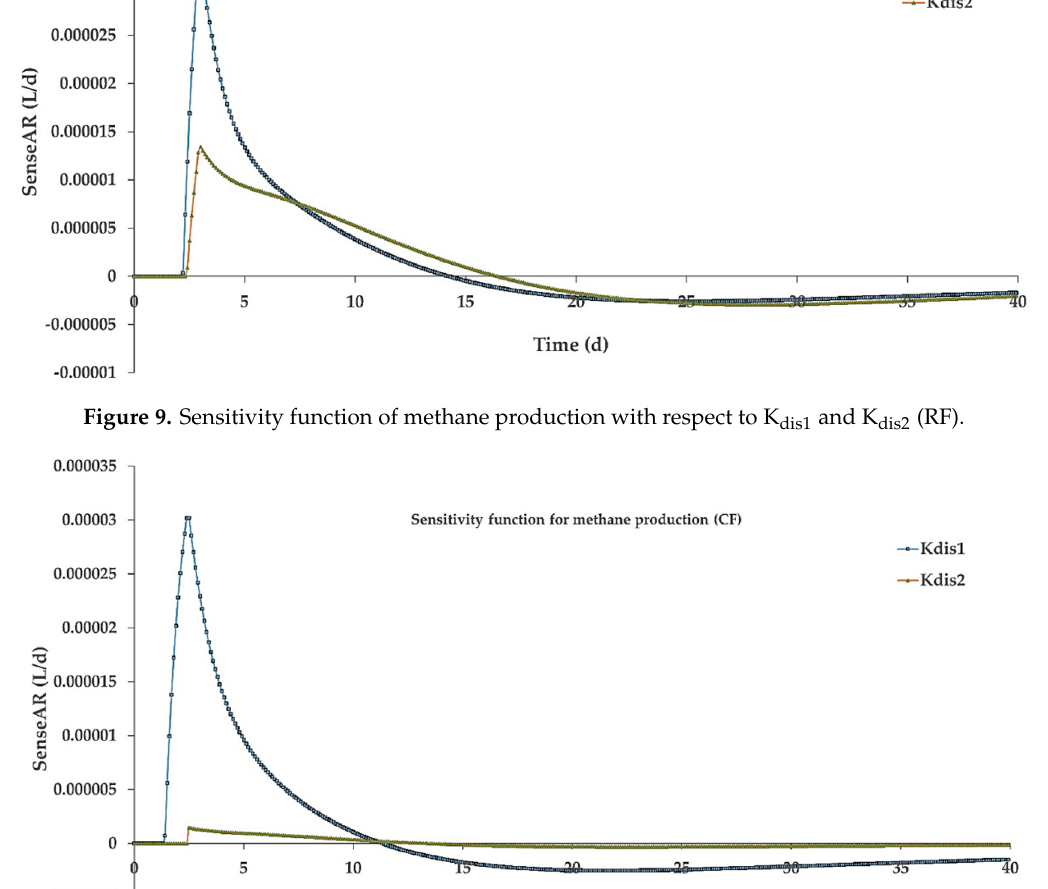
Figure 10. Sensitivity function of methane production with respect to K dis1 and K dis2